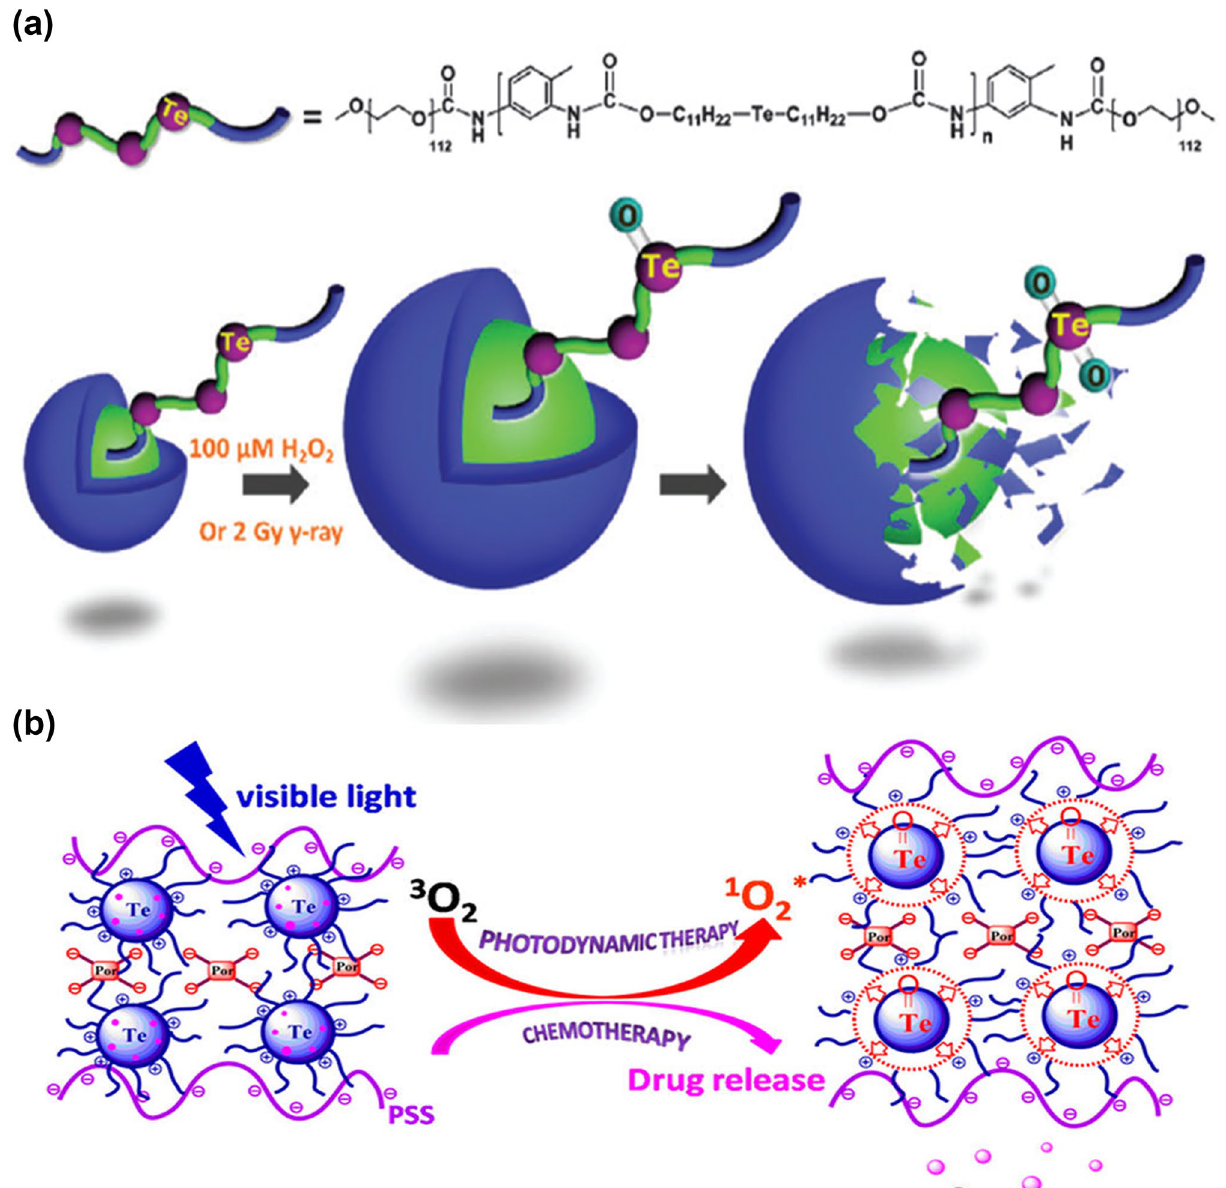
Fig. 14 a Oxidation-responsive organotellurium-containing polymer micelles that could undergo a series of morphological changes triggered by ROS under biologically relevant conditions. Adapted with permission from Ref. [72]. Copyright 2014 American Chemical Society. b Visible light-responsive tellurium-containing multilayer film. Adapted with permission from Ref. [73]. Copyright 2016 American Chemical